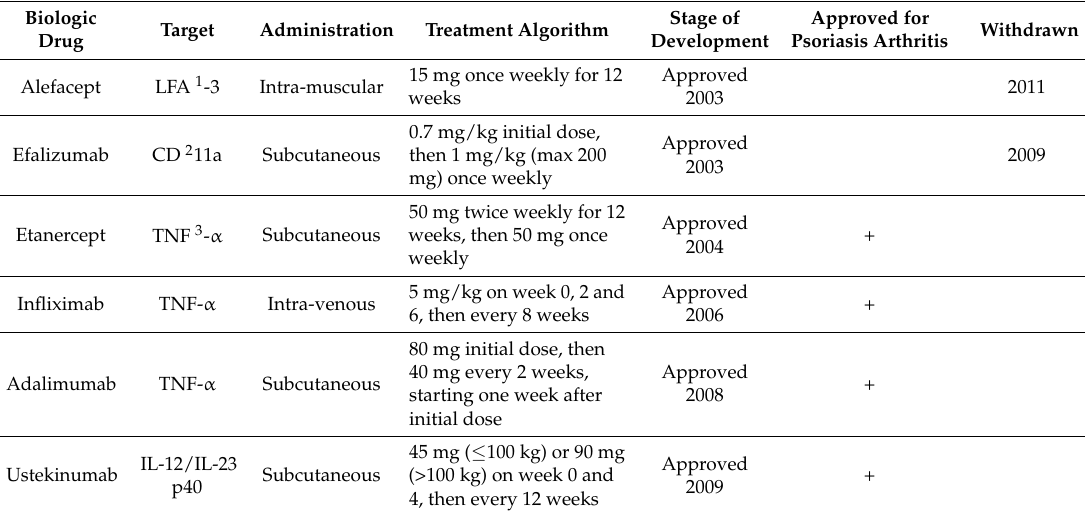
Table 1. Biologics approved for psoriasis by the United States Food and Drug Administration as of June 2017.